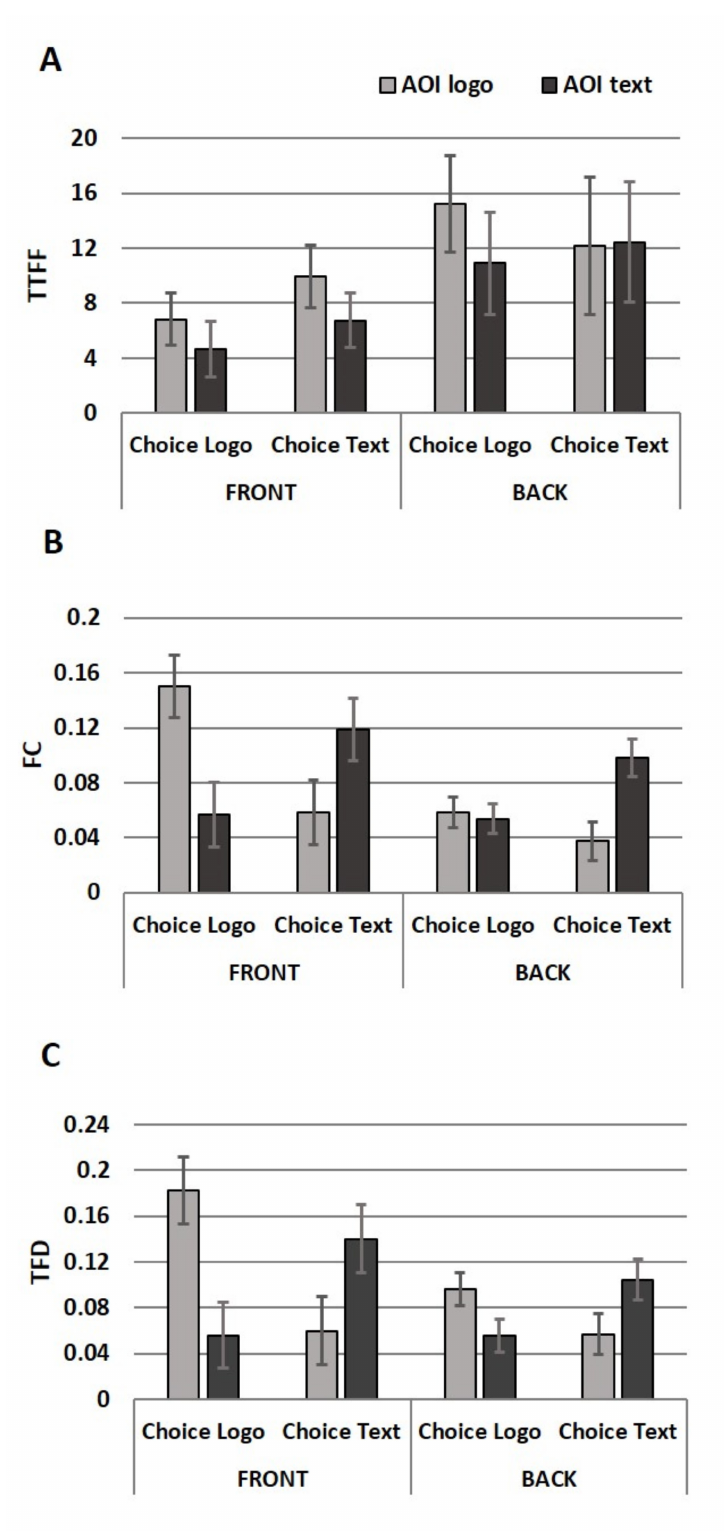
Figure 3. Eye-tracker metrics associated with both AOI-logo and AOI-text depending on consumer choice (logo-label or text-label). ( A ) Time to first fixation (TTFF), ( B ) Fixation Counts (FC) and ( C ) Total fixation duration (TFD). An ANOVA was performed independently of the front- and back-labels. Vertical bars represent the LSD interval ( p -value < 0.05). TTFF is expressed as seconds. FC and TFD are relative values (sec) after normalizing